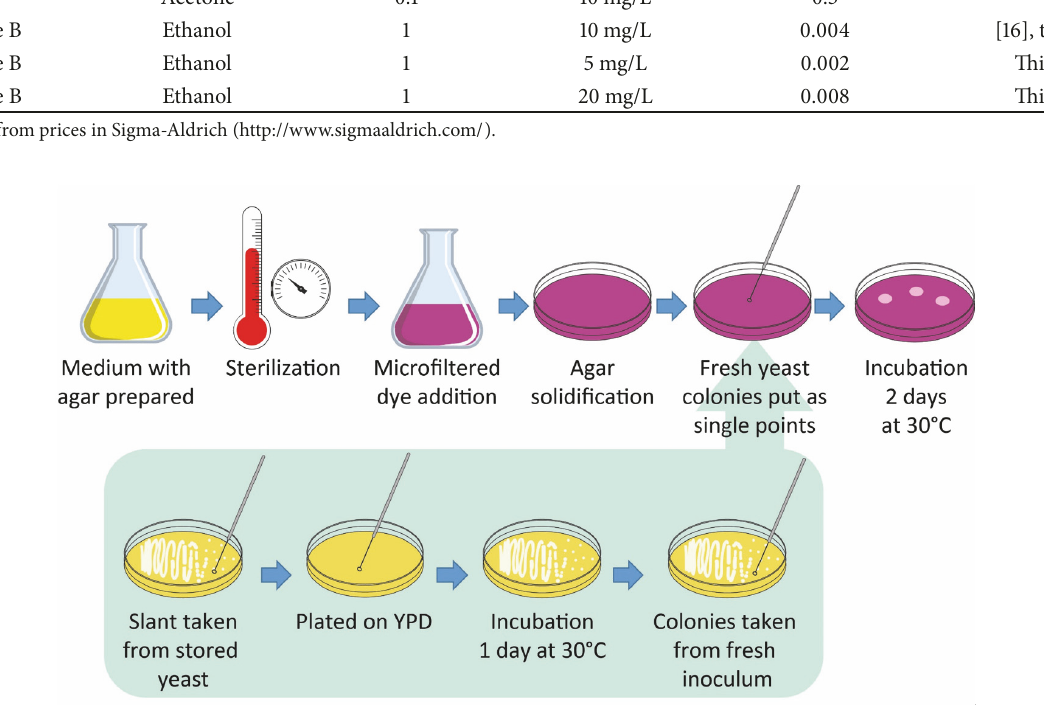
Figure 1: Diagram of the proposed procedure using the selected dye, Rhodamine